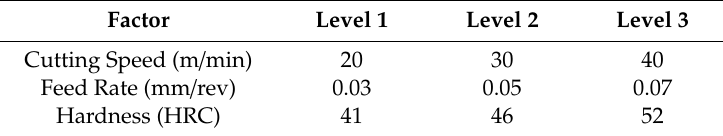
Table 3. Factors and levels for testing Rene 65 drilling tests.